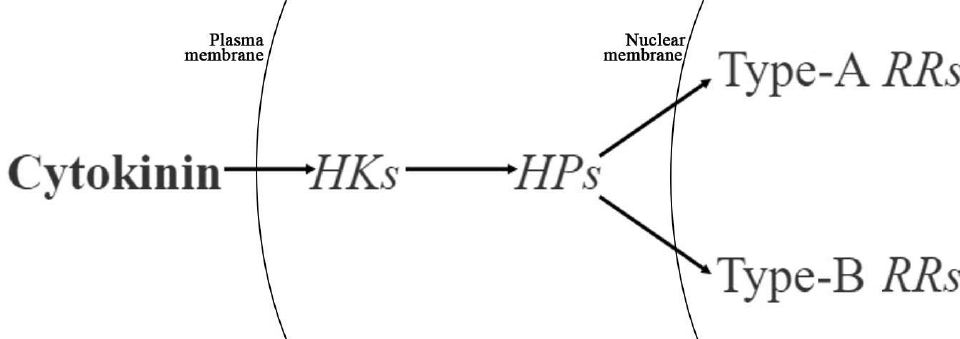
Figure 11. Model of cytokinin signaling (Adapted from To et al. [ 32 ] ).